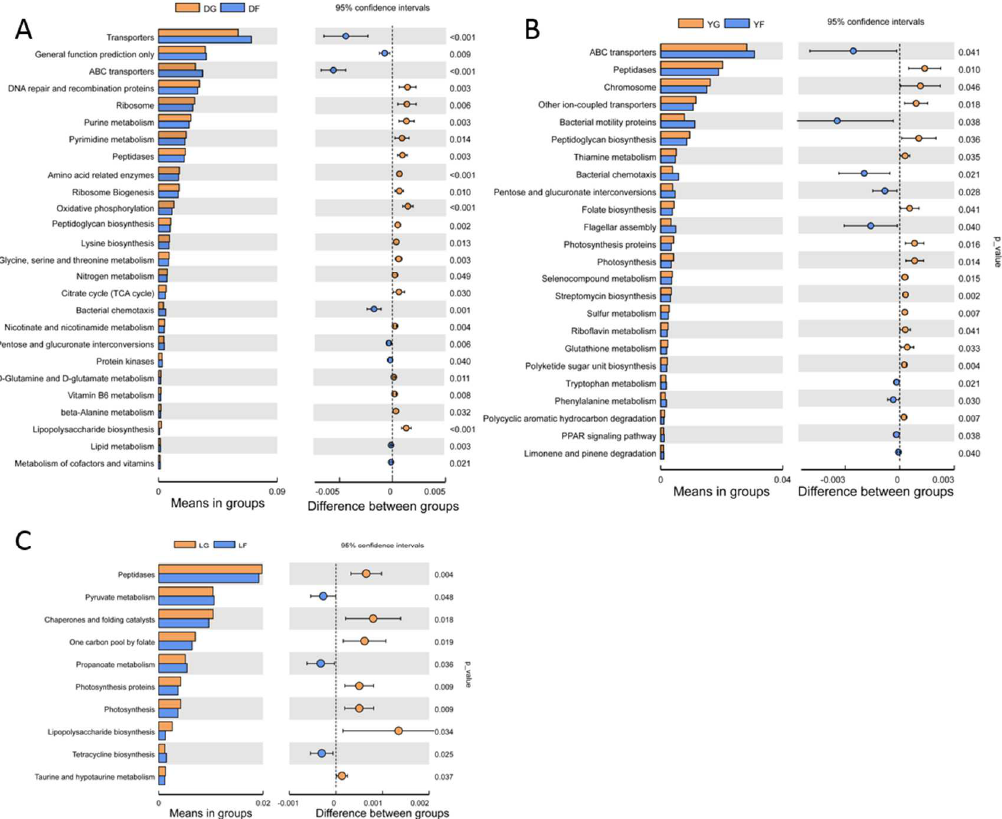
Figure 7. Differences in the abundance of annotated KEGG levels (level 3) of gut microbiota composition of pigs of three different breeds at the different growth stages based on T-test analysis. ( A ) Duroc pigs. ( B ) Landrace pigs. ( C ) Yorkshire pigs. Extended error bar plot significant differences between early and finishing growth stages with corrected p values shown on the right.